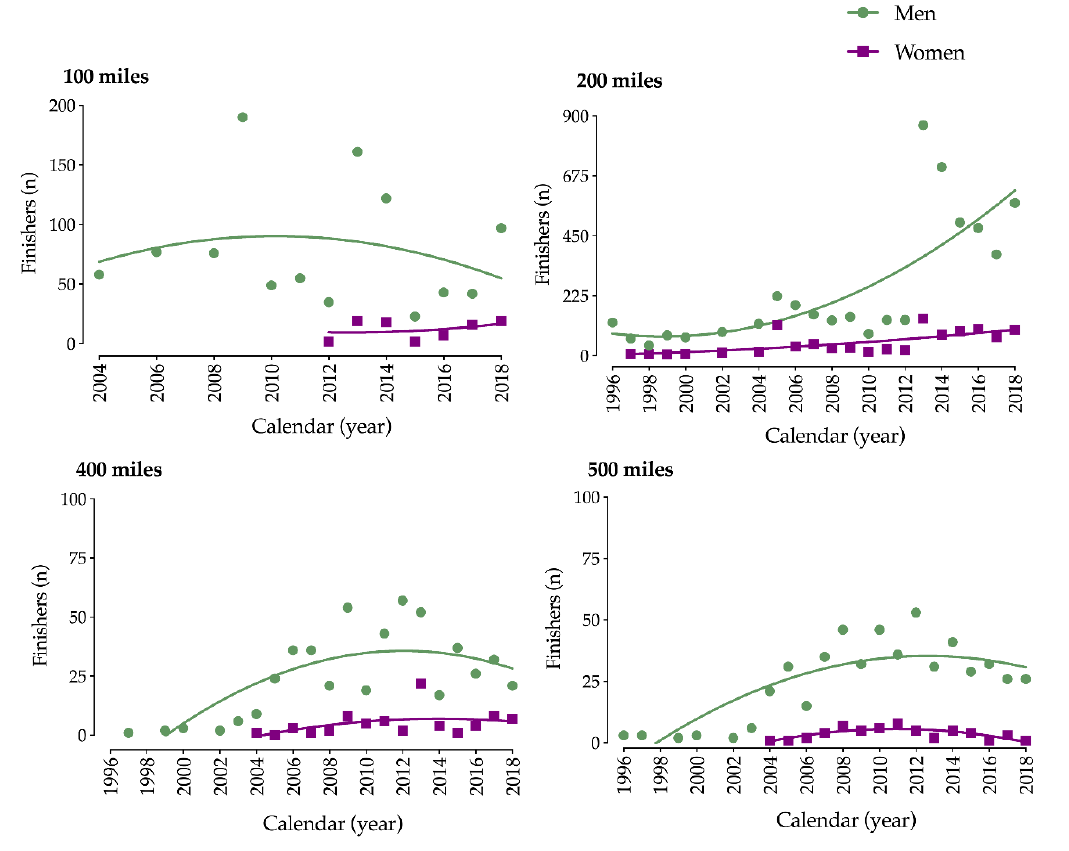
Figure 1. Number of male and female participants in ultra-distance cycling in 100–500 mile races from 1996 to 2018. * Outlier point (n = 190).